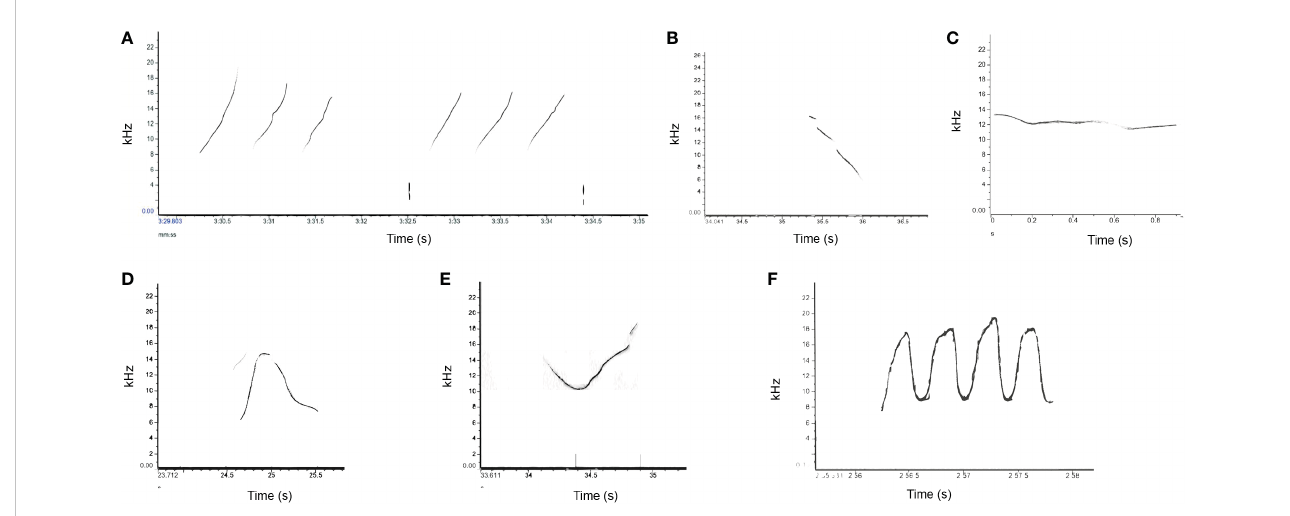
FIGURE 4 Examples of each whistle types: (A) whistle type A (upsweep), (B) whistle type B (downsweep), (C) whistle type C ( fl at), (D) whistle type D (convex), (E) whistle type E (concave), and (F) whistle type F (multiloop), recorded in Taranto Gulf and Boka